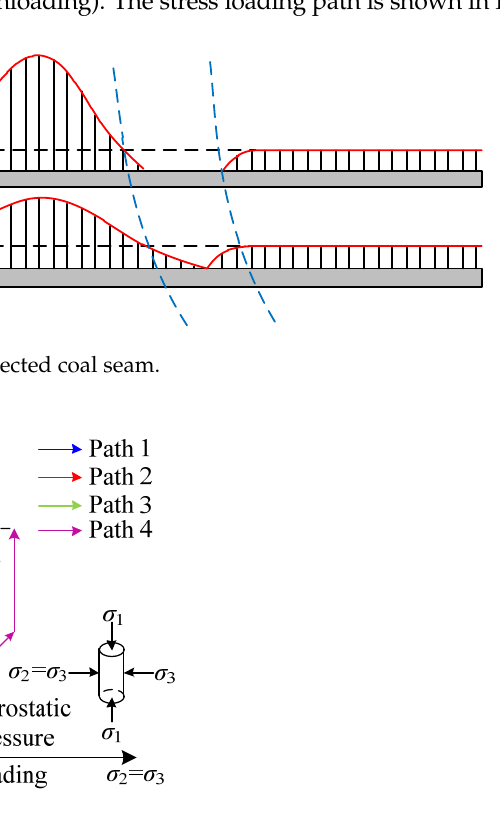
Figure 5. Schematic diagram of experimental stress path. Table 2. Physical and mechanical parameters of the experimental coal sample.